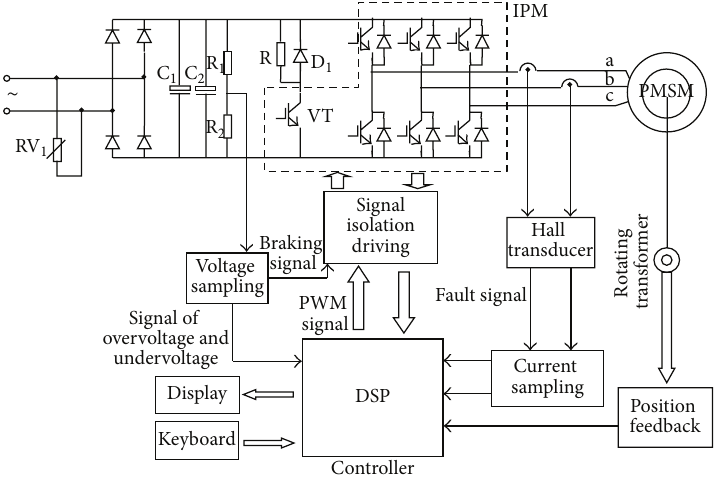
Figure 13: The structure diagram of control system.